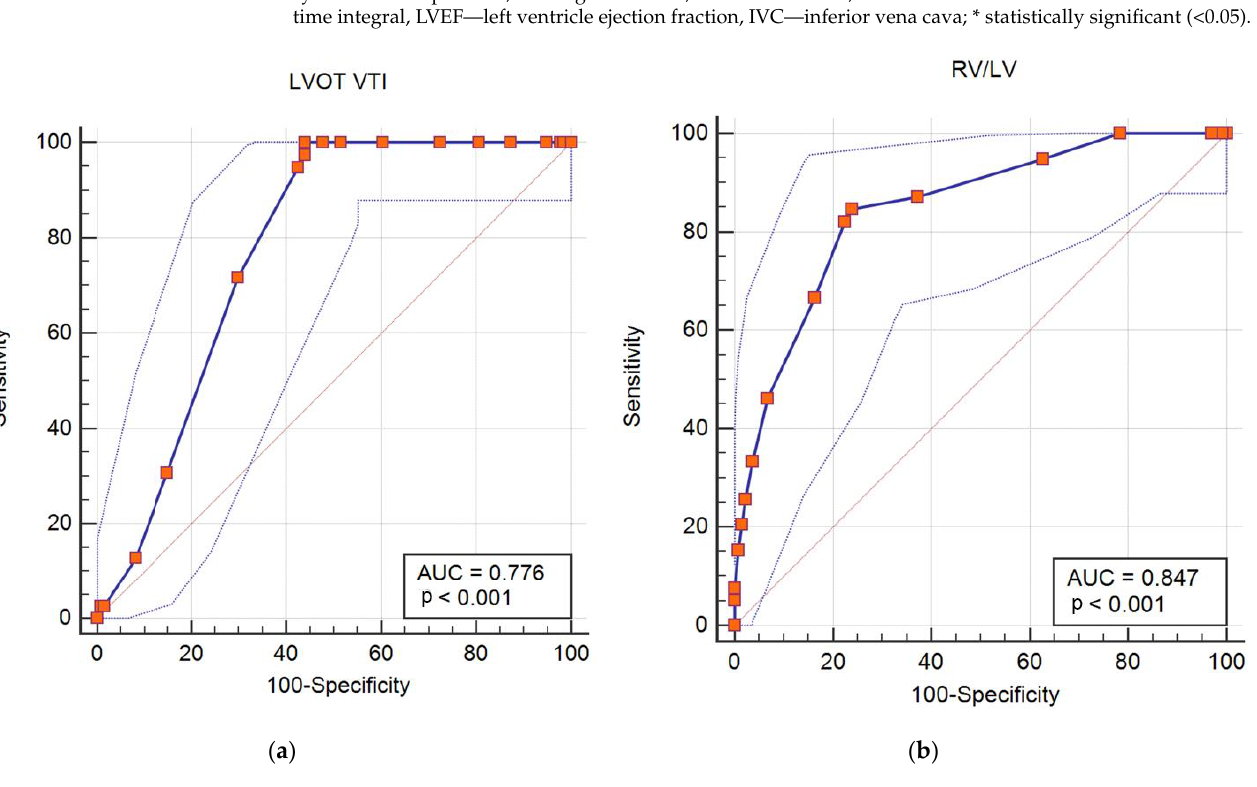
Figure 5 . ROC curves for adverse events prediction in intermediate-high risk PE . In the intermediate low risk PE group, there were 11 adverse events (22%). LVOT VTI ≤ 15 cm was recorded in all the patients with adverse outcome. The sensitivity of a LVOT VTI ≤ 15 cm was 100%, specificity was 99.6%, the positive predictive value was 93.87% and the negative predictive value was 100%.